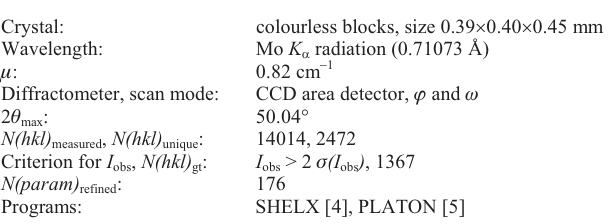
Table 1. Data collection and handling.